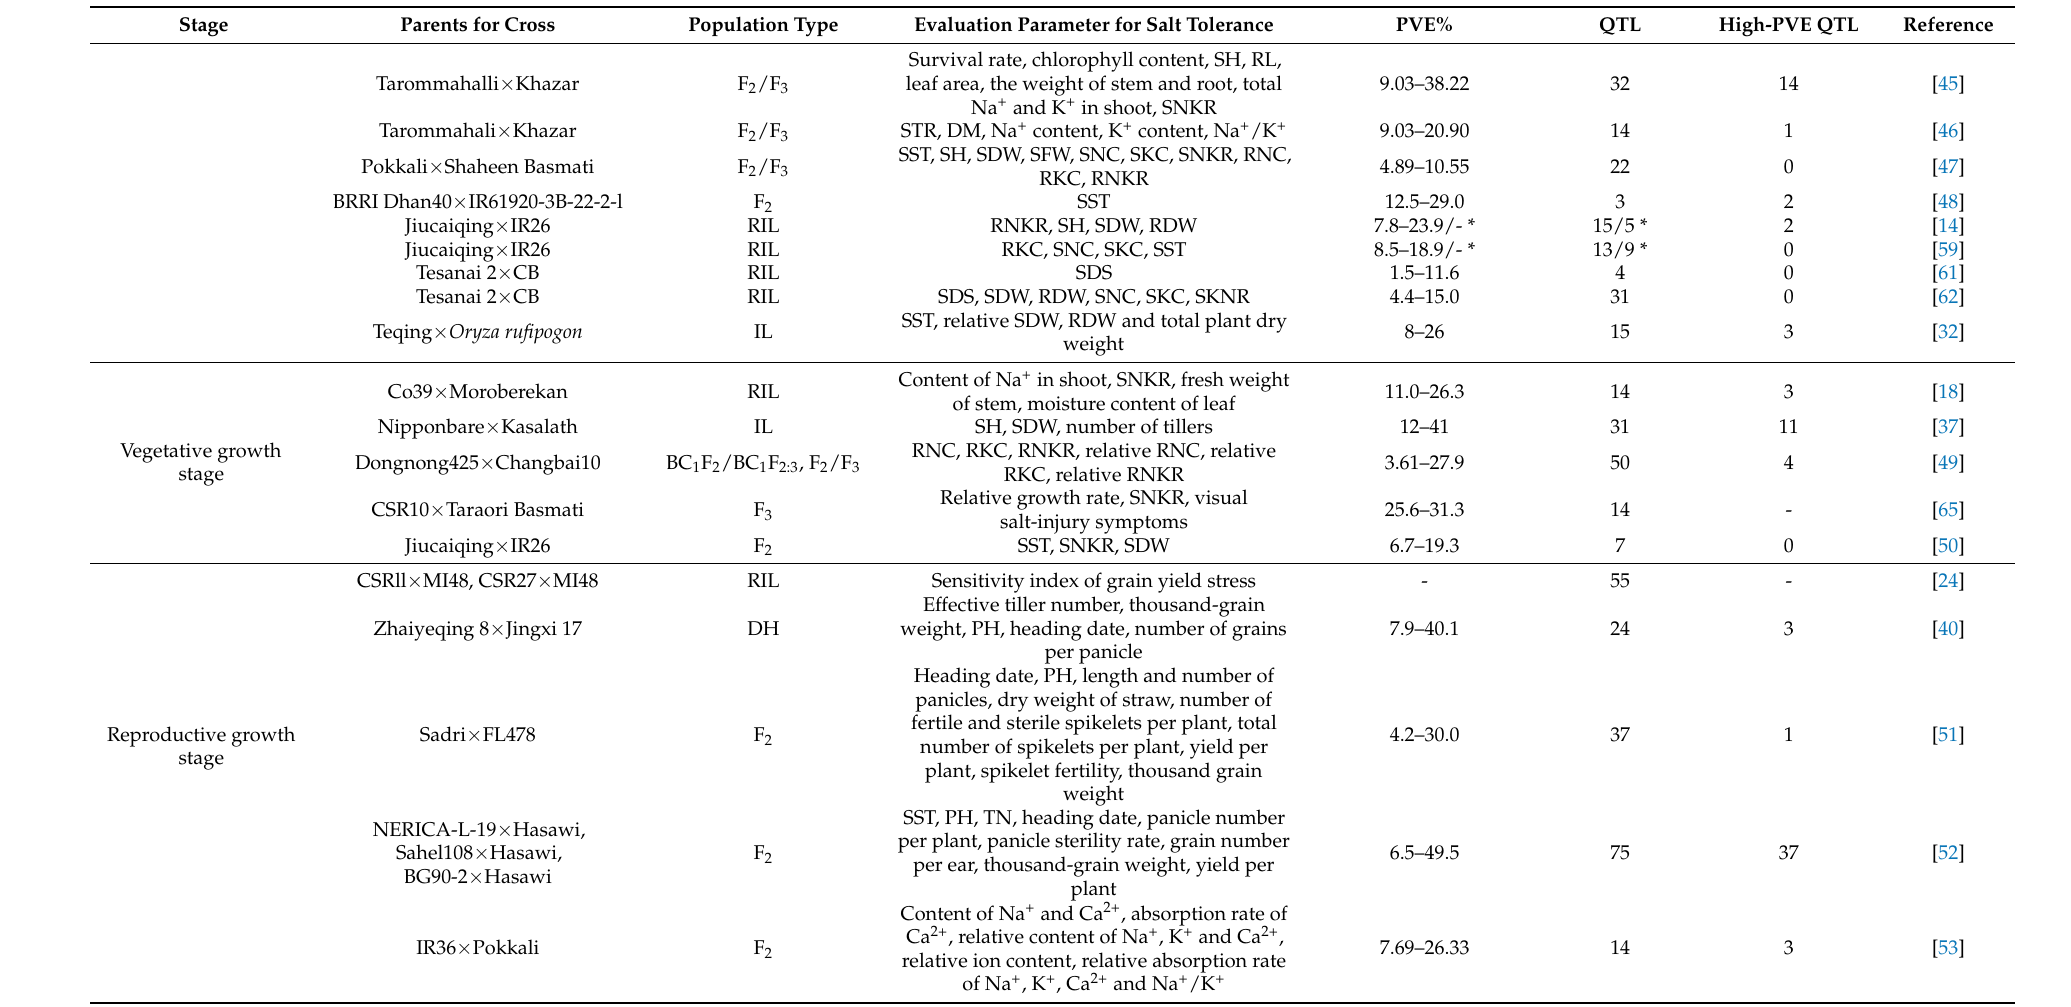
Heading date, PH, length and number of panicles, dry weight of straw, number of fertile and sterile spikelets per plant, total number of spikelets per plant, yield